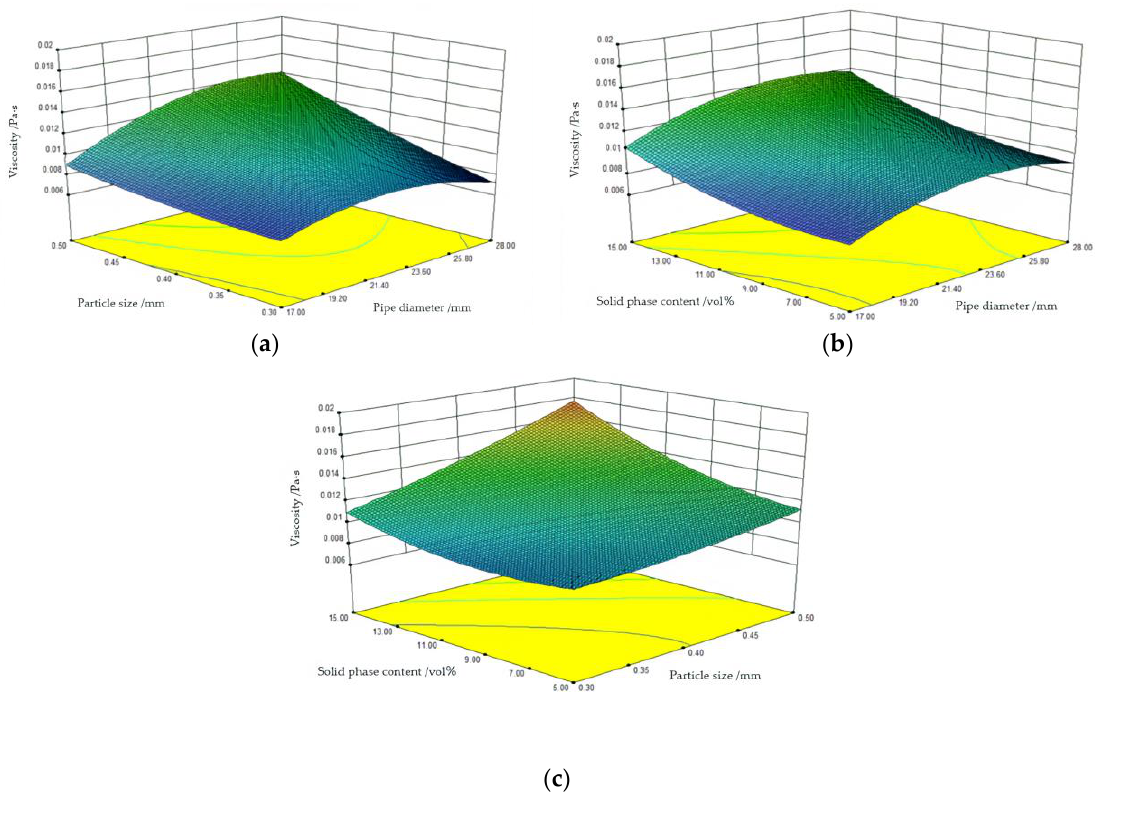
Figure 10. Response surface graphs for the interaction of three factors on viscosity. ( a ) The effect of pipe diameter and particle size on viscosity; ( b ) The effect of pipe diameter and solid content on viscosity; and ( c ) The effect of particle size and solid content on viscosity.